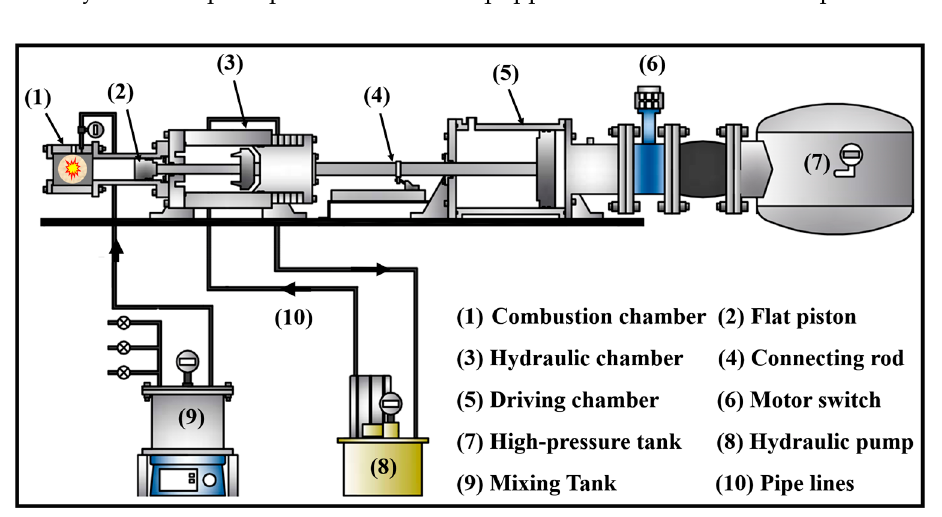
Figure 1. Schematic of high-strength optical rapid compression machine setup.